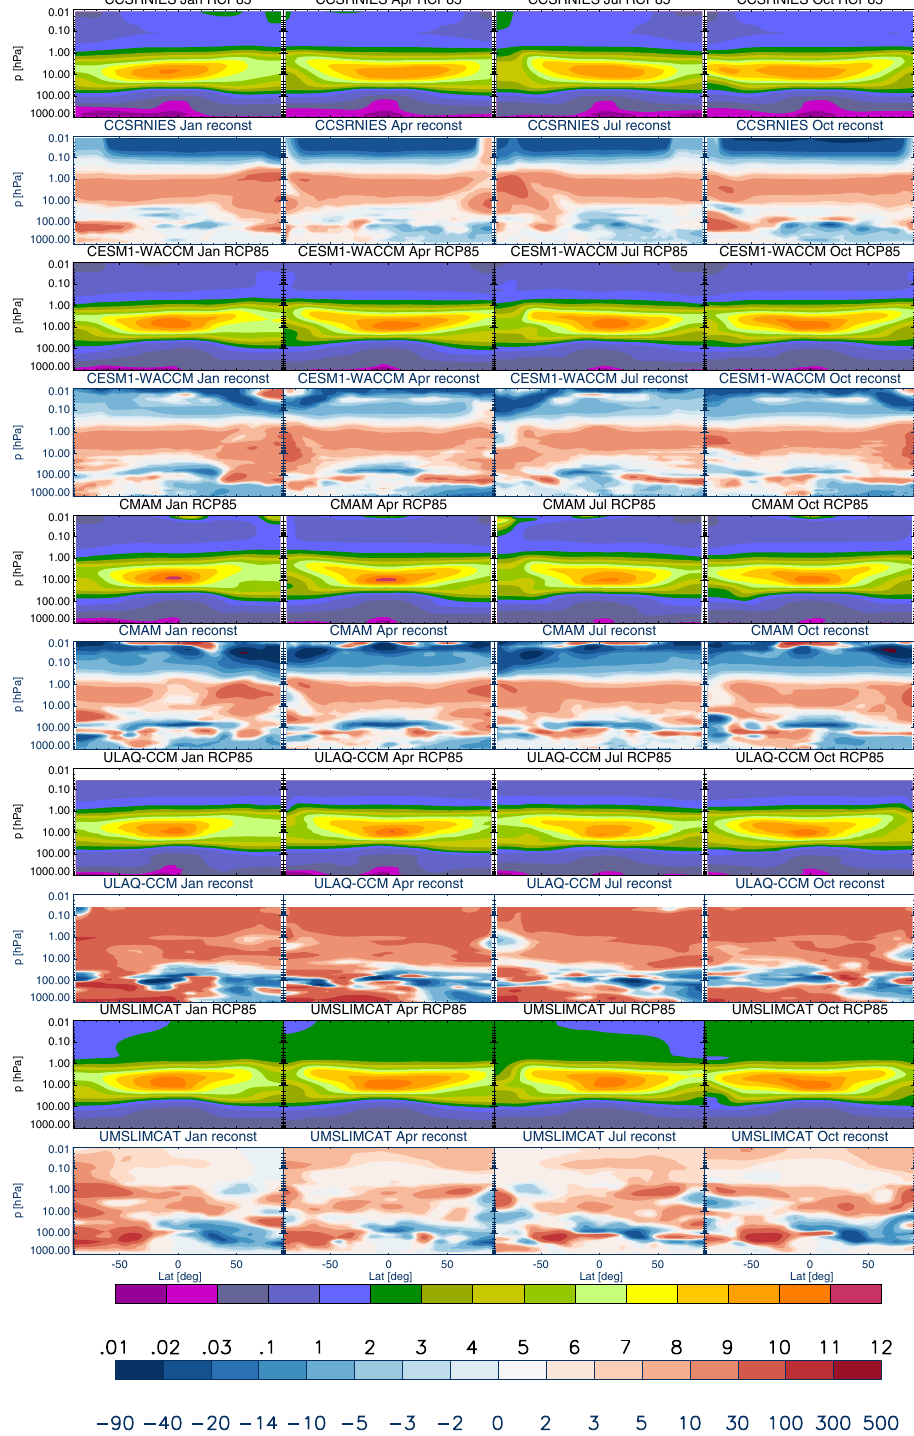
Figure 14. Rows 1, 3, 5, 7, and 9: zonal-mean ozone (ppmv), averaged individually for the months of January, April, July, and October, for the years 2090–2099 of the RCP 8.5 scenario, as simulated by the CCSRNIES-MIROC3.2, CESM1-WACCM, CMAM, ULAQ-CCM, and UMSLIMCAT models. Rows 2, 4, 6, 8, and 10: percentage difference between the rescaled and simulated ozone fields. The rescaling is based on the REF-C2 simulations and the a , b , and d coefficients as derived versus the SEN-C2-fCH4, -fN2O, and -fGHG simulations. Note that the ODSs evolve identically in REF-C2 and in